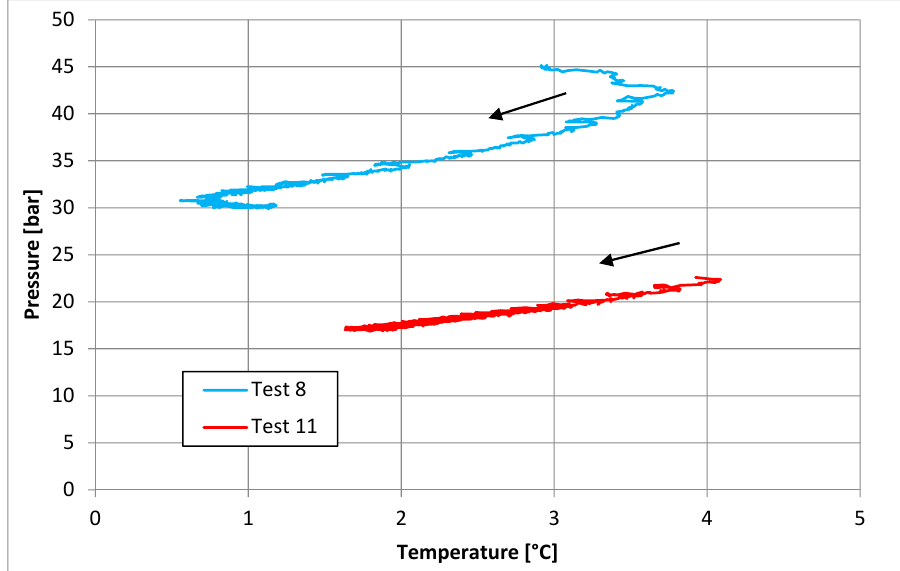
Figure 8. Comparison between Test 8, carried out using CH 4 , and Test 11, performed with CO 2 .